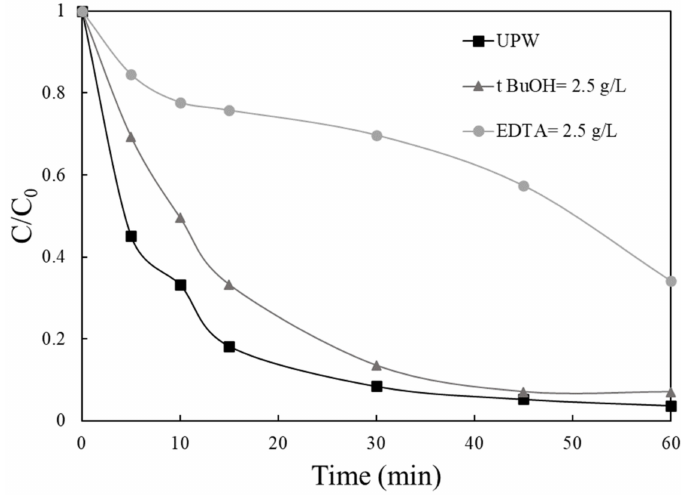
Figure 10. Effect of scavengers on the degradation of 0.5 mg/L VLS with 1000 mg/L 0.25 MoS 2 /BiOCl.